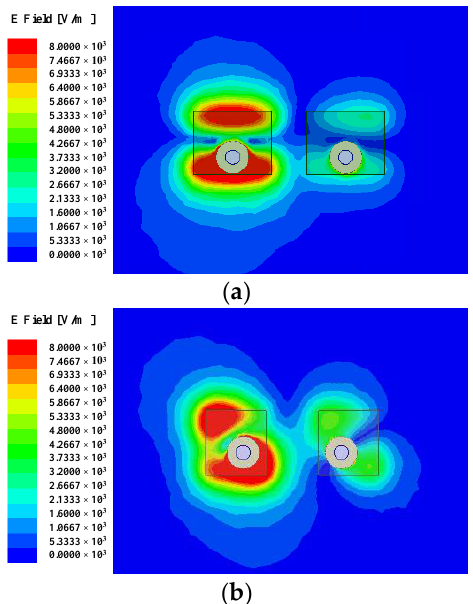
Figure 5. Electric filed distribution for the reference and proposed antenna arrays. ( a ) Reference. ( b ) Proposed.